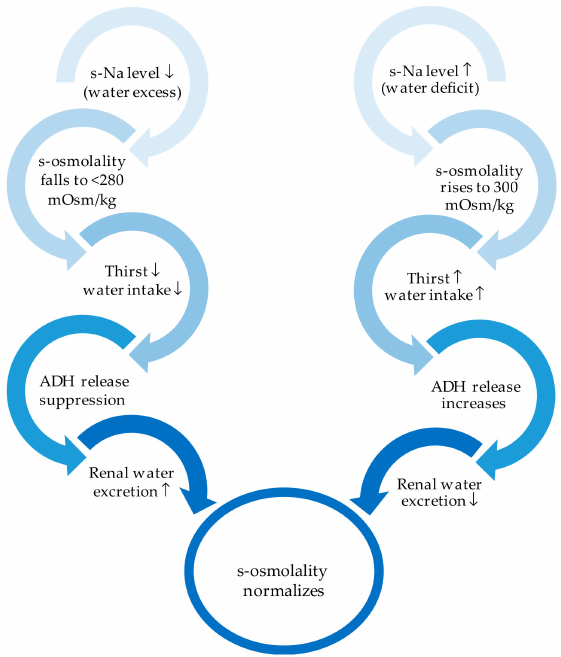
Figure 5. Regulation mechanisms of sodium and water. s-Na: Serum sodium; s-osmolarity: Serum osmolarity; ADH: Antidiuretic hormone.